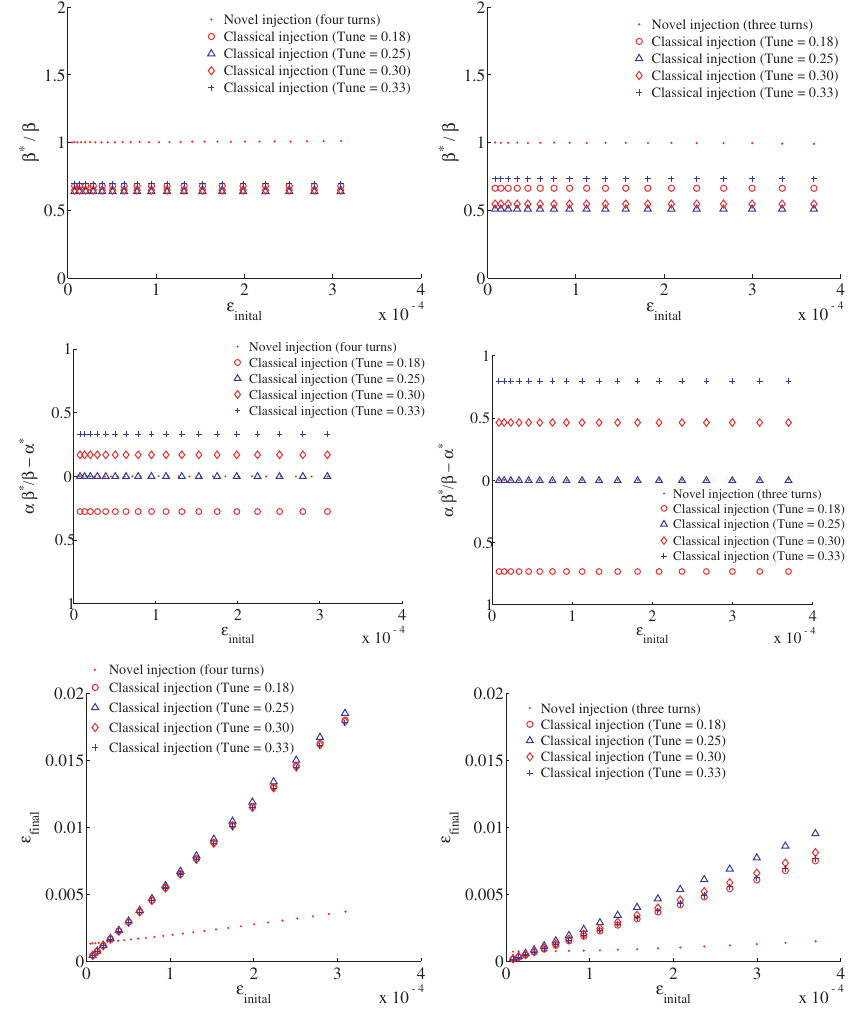
FIG. 12. (Color) Optical mismatch parameters and final emittance as a function of the initial emittance of the injected beam for simple model of the classical multiturn injection (markers) and the proposed multiturn injection based on the fourth-order resonance (left) and the third-order one (right). Four values of the linear tune have been considered for the classical multiturn